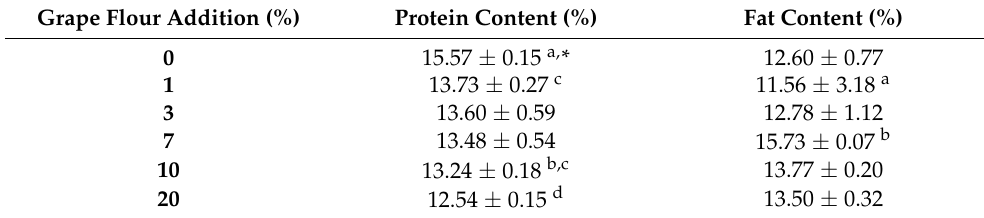
Table 4. Protein content of experimentally produced vegan sausages. Grape Flour Addition